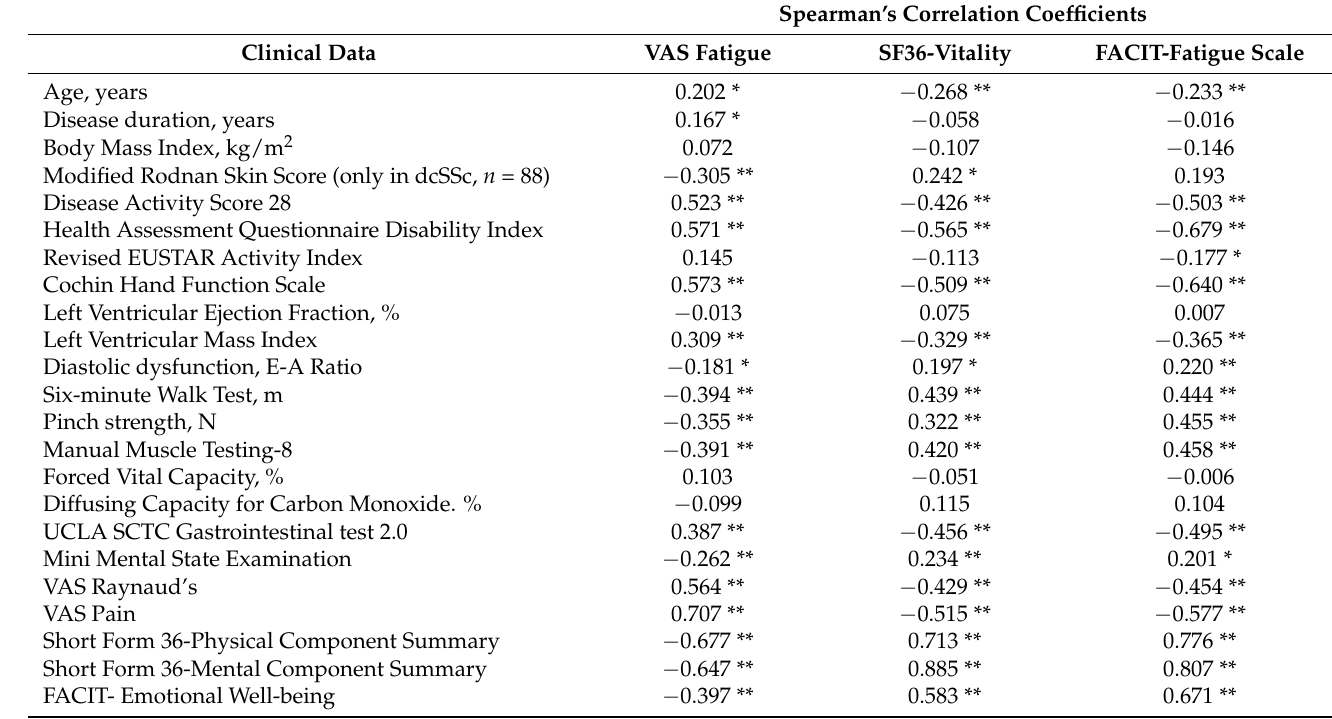
Table 2. Correlations between baseline parameters and fatigue measures among 160 SSc